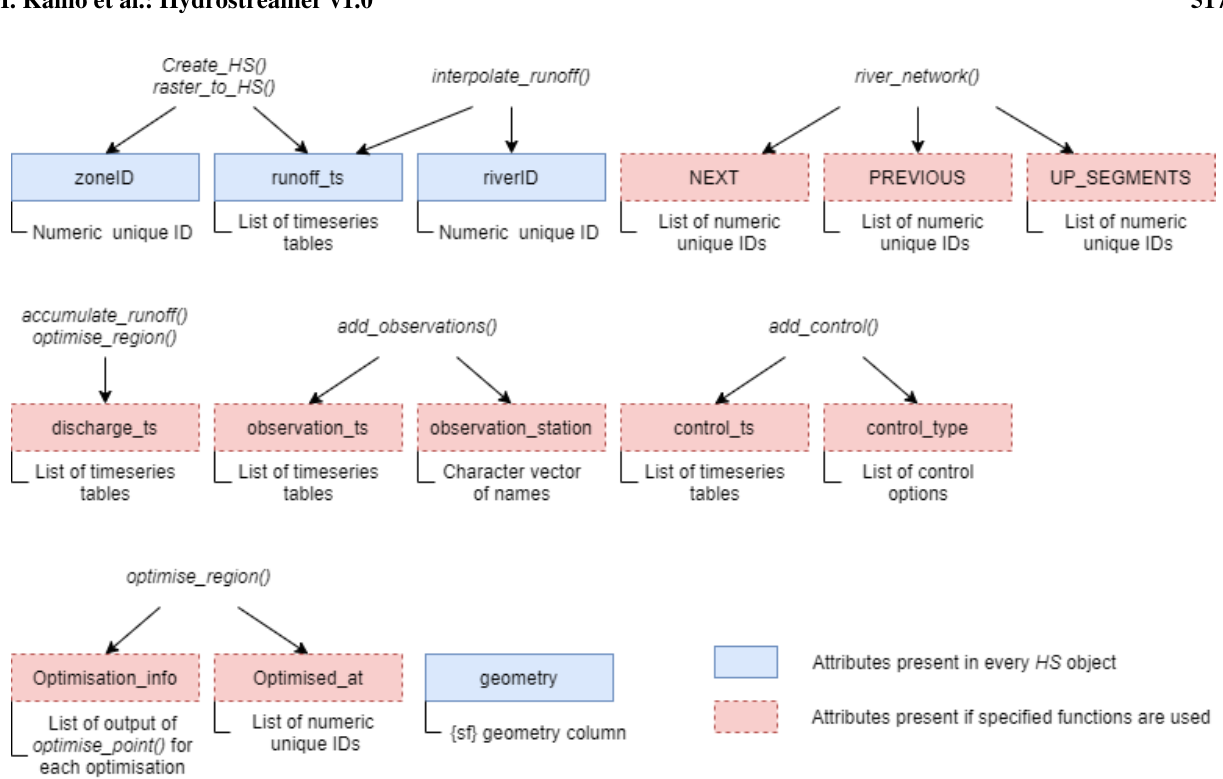
Figure A1. Attribute columns which may be added by Hydrostreamer functions to an HS object and the functions which include them.